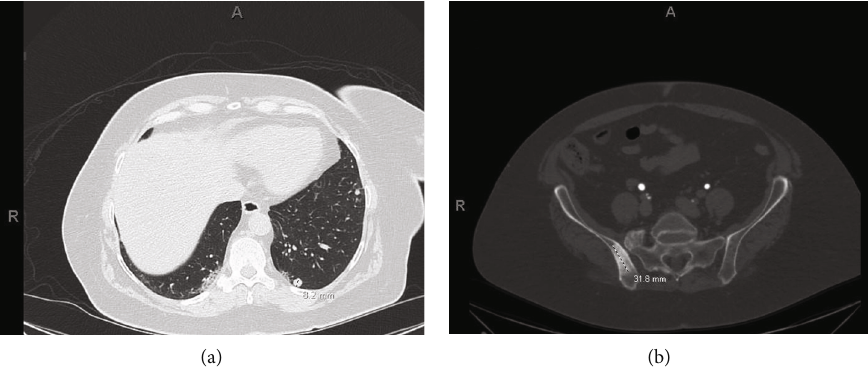
Figure 3: (a) A follow-up CT of the abdomen/pelvis revealed multiple new and enlarging pulmonary nodules in bilateral lungs, and a new sclerotic lesion in the right ilium (b).